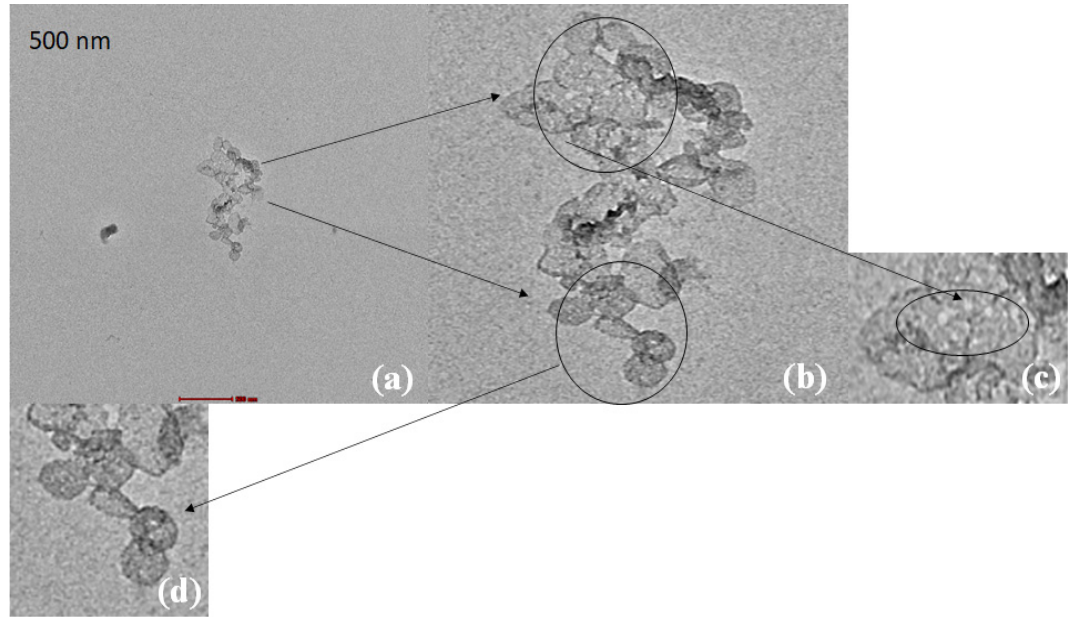
Fig. 7. Transmission Electron Microscopy analysis of the cotton straw